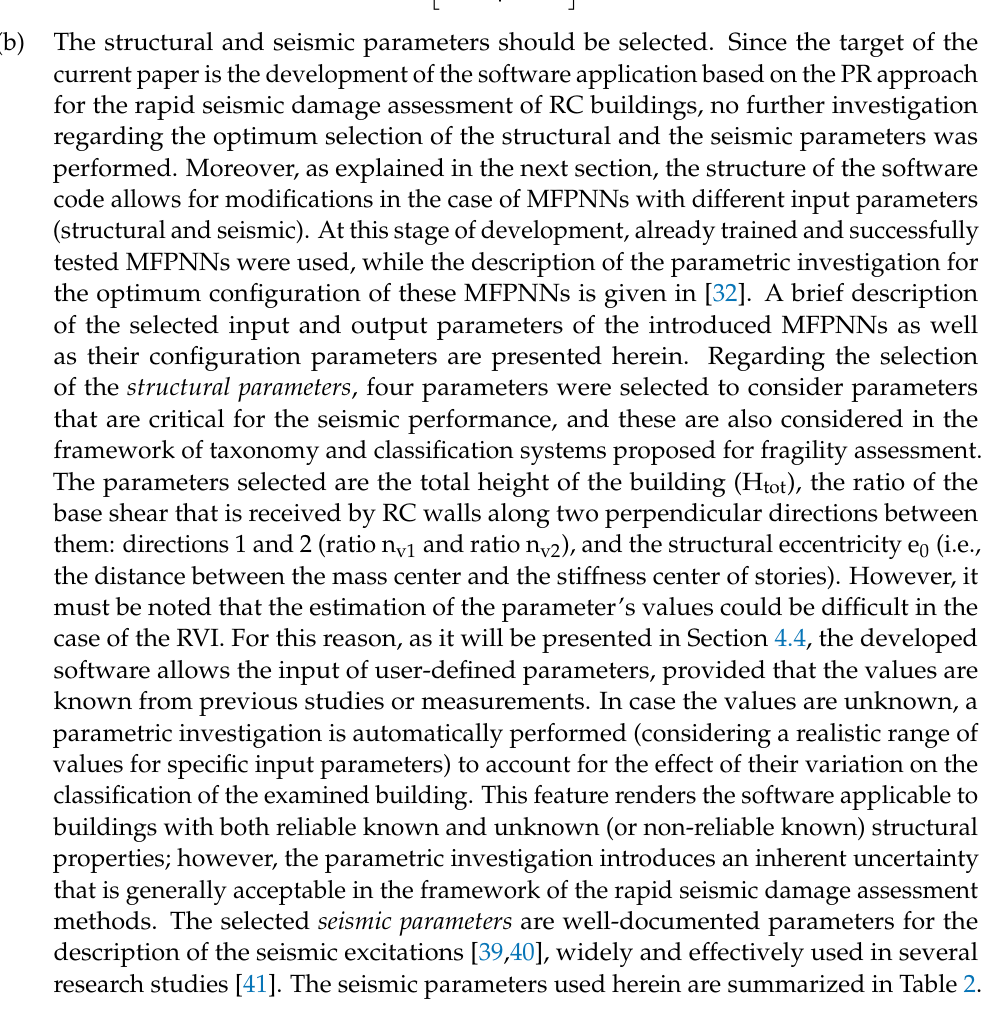
Table 2. The seismic parameters of the input vectors for the trained MFPNNs of the developed soft- ware.